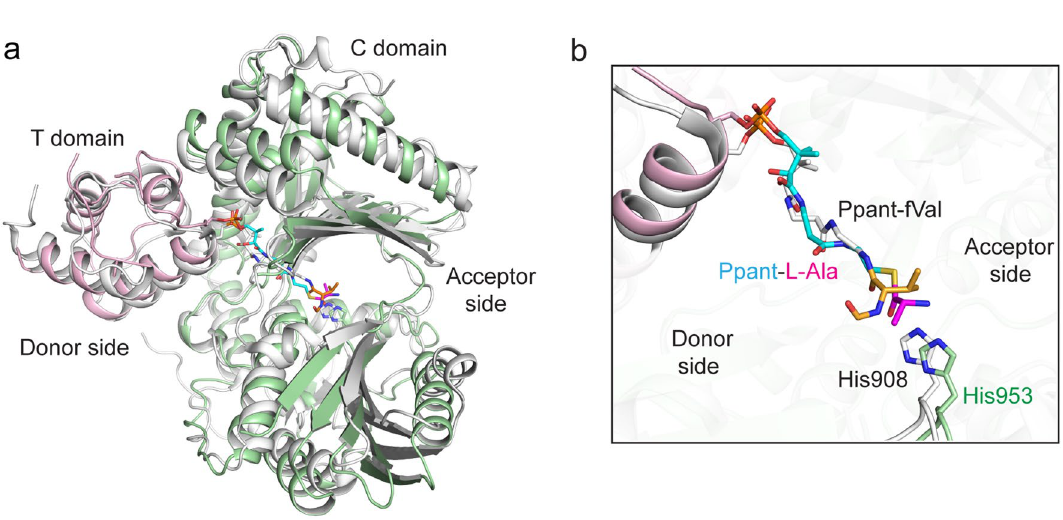
Figure 3. Superimposed structures of T–C bidomains of AmbB and LgrA. ( a ) In both structures, the T domain and C domain adopt similar orientation (RMSD value of 2.60 Å for 345 Cα). The T domain binds to the donor side of the C domain in both proteins. The F–A domains of LgrA is not shown for clarity. The T domain of AmbB is coloured pink and the C domain, green, whereas LgrA is coloured gray. ( b ) Close-up view of Ppant-L-Ala (yellow and magenta sticks) and Ppant-fVal (gray) in the C domain of AmbB (chain B) and LgrA, respectively. In both structures, Ppant-l-Ala and Ppant-fVal point towards the putative catalytic residues, His953 (AmbB) and His908